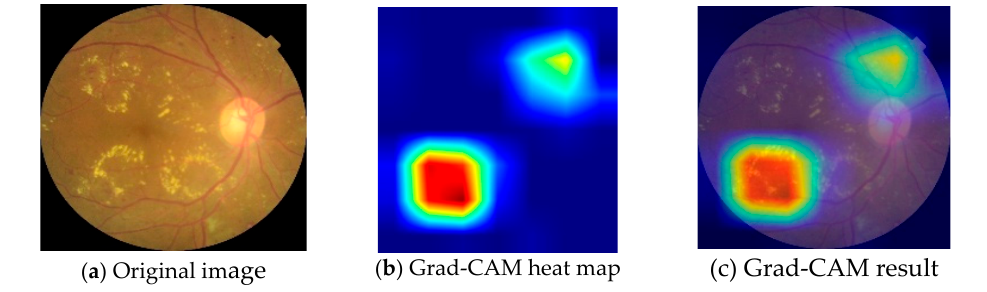
Figure 4. Visualization results produced by Grad-CAM .